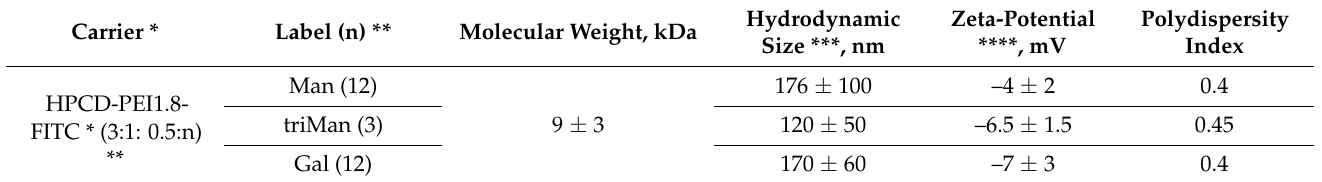
Table 1. Characteristics of drug delivery systems and their affinity to mannose receptor.